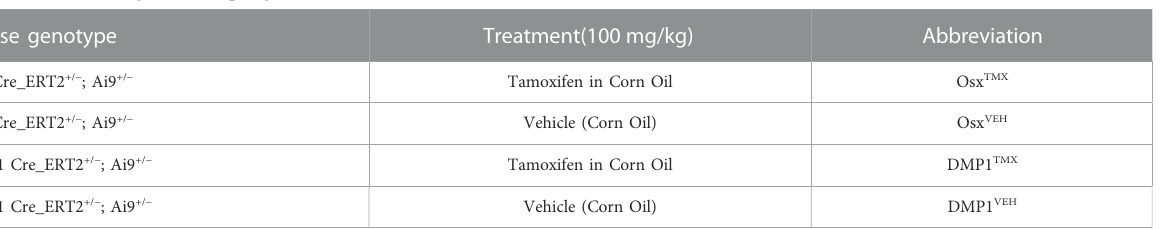
TABLE 1 Overview of experimental